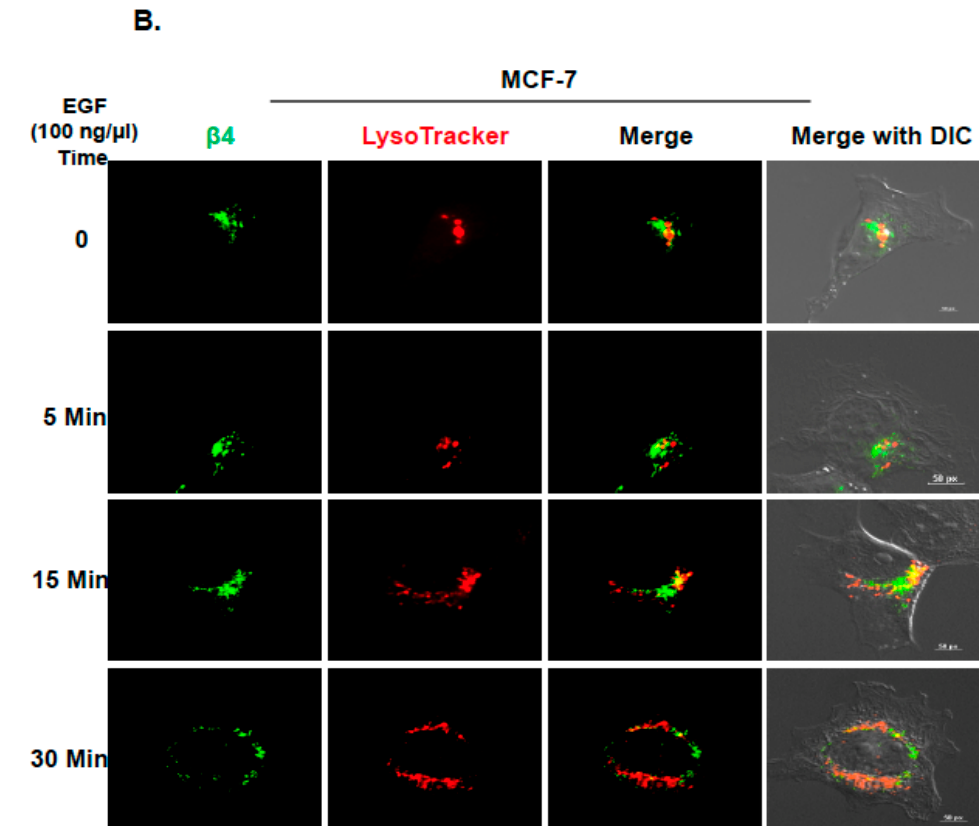
Figure 3. ITG β 4 degradation by ARRDC3 is associated with lysosomal targeting of endosomal ITG β 4. ( A ) MDA-MB-231 cells were transfected with HA-ARRDC3 plasmid. Next day, the cells were incubated with LysoTracker ® Red DND-99 (red) before EGF treatment (20 ng/ µ L) for the indicated time periods. The cells were fixed and stained with fluorescence-labeled antibodies against HA (ARRDC3; blue) and ITG β 4 (green). Scale bar: 50 µ m. ( B ) MCF-7 cells were incubated with LysoTracker ® Red DND-99 (red) before EGF treatment (100 ng/ µ L) for the indicated time periods. The cells were fixed and stained with fluorescence-labeled antibodies against ITG β 4 (green). All images were captured by a fluorescence microscope with DIC optic. Scale bar: 50 µ m. Representative images were selected from three independent experiments.